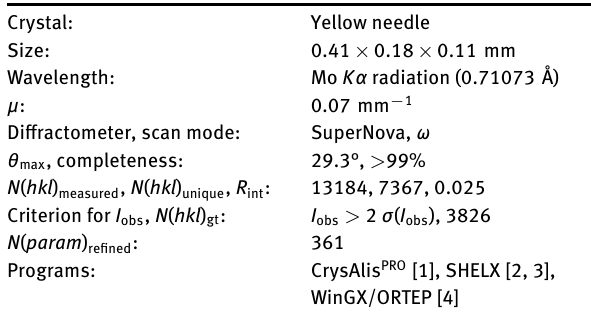
Table 1: Data collection and handling.